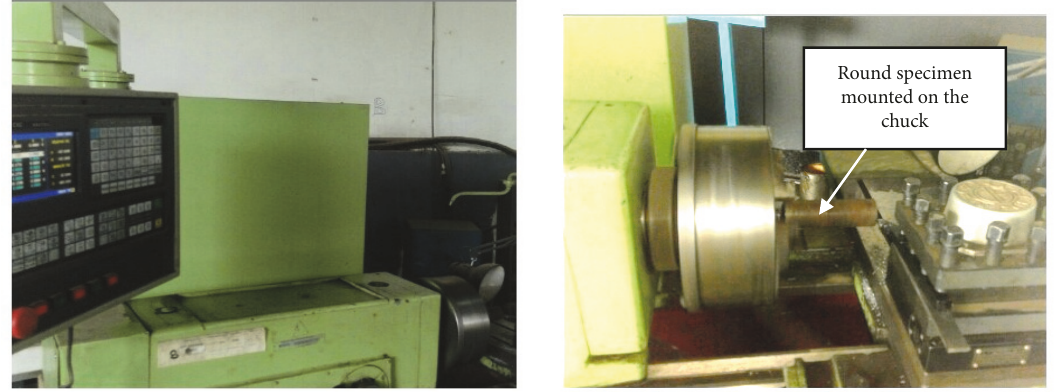
Figure 2: Experimental setup on CNC center lathe (TOS-TRENCIN sn40 UPGRADED GSK CNC 980TDb) for the turning operation of specimen of CSN 12050 carbon steel.